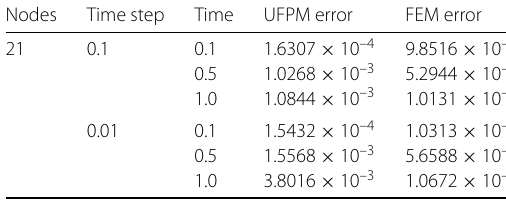
Table 4 Comparison of calculation results of UFPM and FEM Nodes Time step Time UFPM error FEM